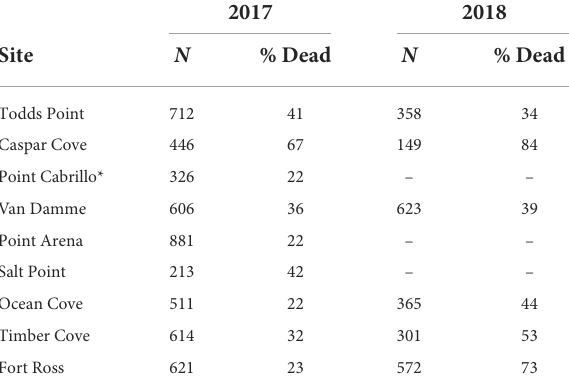
TABLE 2 Summary results of logistic regression model